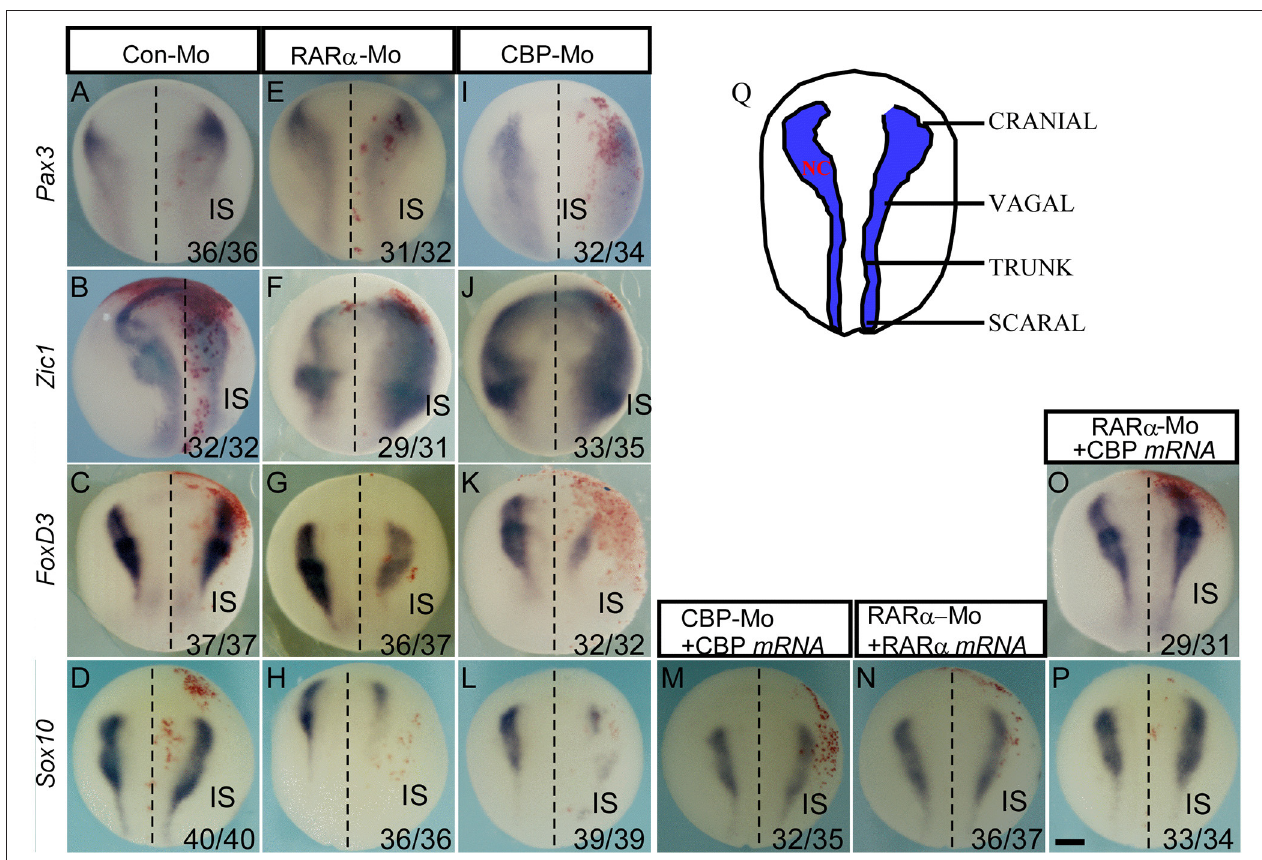
FIGURE 4 | CBP functions downstream of RAR α in regulating neural crest induction. The effects of the control morpholino (A–D) , RAR α knockdown (E–H) and CBP knockdown (I–L) on the expression of indicated neural border and neural crest markers. (M,N) The RAR and CBP morpholino-induced reduction in Sox10 is rescued by coinjection of morpholino-resistant RAR and CBP mRNAs, respectively. (O,P) The RAR α knockdown-induced inhibition of FoxD3 and Sox10 is rescued by CBP mRNA coinjection. All of the embryos were collected at stage 15–16. (Q) Schematics of neural crest from the dorsal view along the anterior-posterior axis at stage 15. IS means injected side, and the left and right embryo halves are denoted with the dashed line. The numbers of embryos showing similar changes of gene expression and the total injected embryos in each group are indicated. Scale bar: 100 µ